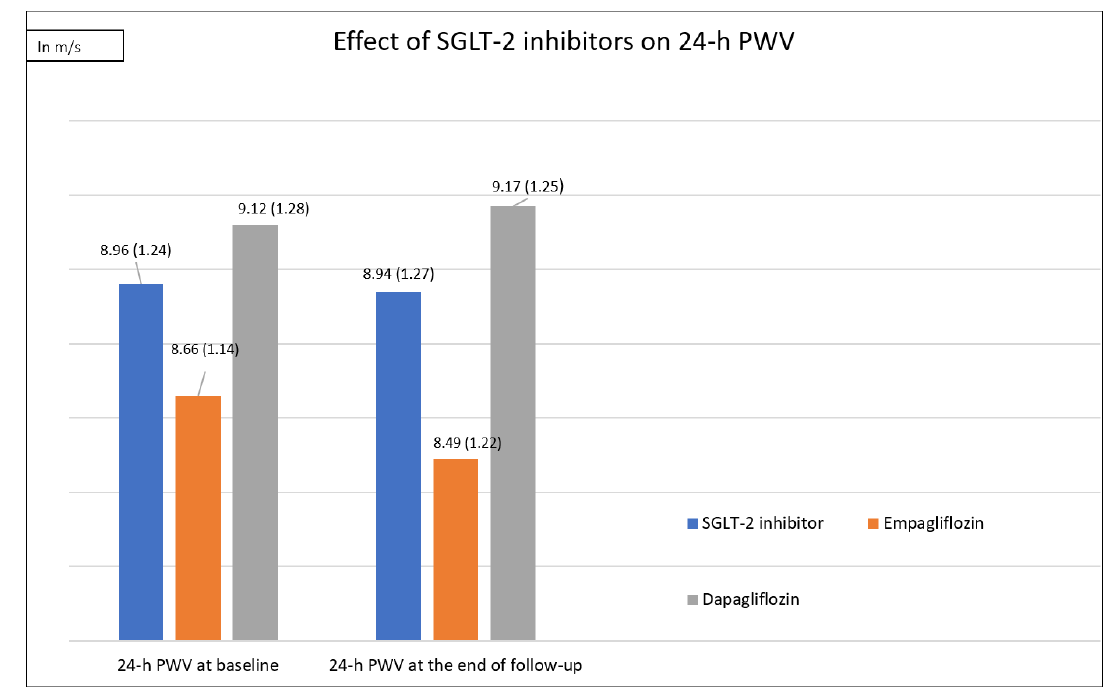
Figure 1. Effect of SGLT-2 inhibitors on 24 h PWV.